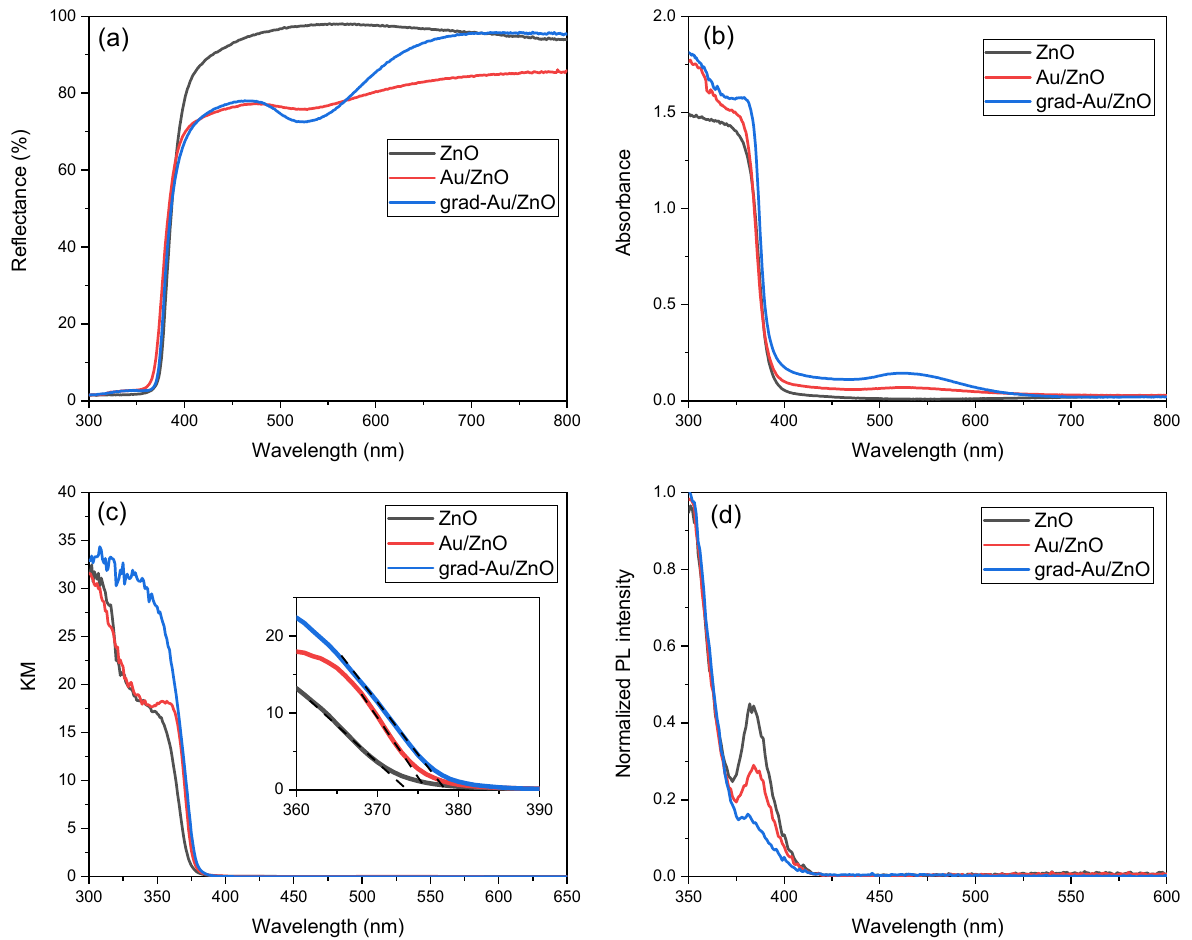
Figure 5. Spectra of ( a ) Reflectance; ( b ) Absorbance; ( c ) Corresponding KM plots; and ( d ) Photolu- minescence of ZnO, Au/ZnO, and grad-Au/ZnO NRs.